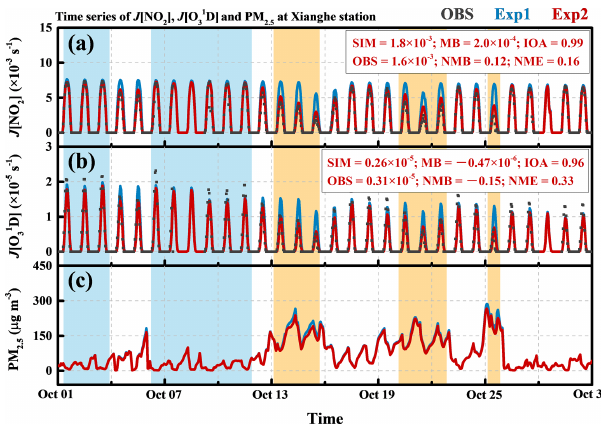
Figure 2. Time series of simulated J (NO 2 ) (a) , J (O 1 PM 2 . 5 (c) at Xianghe